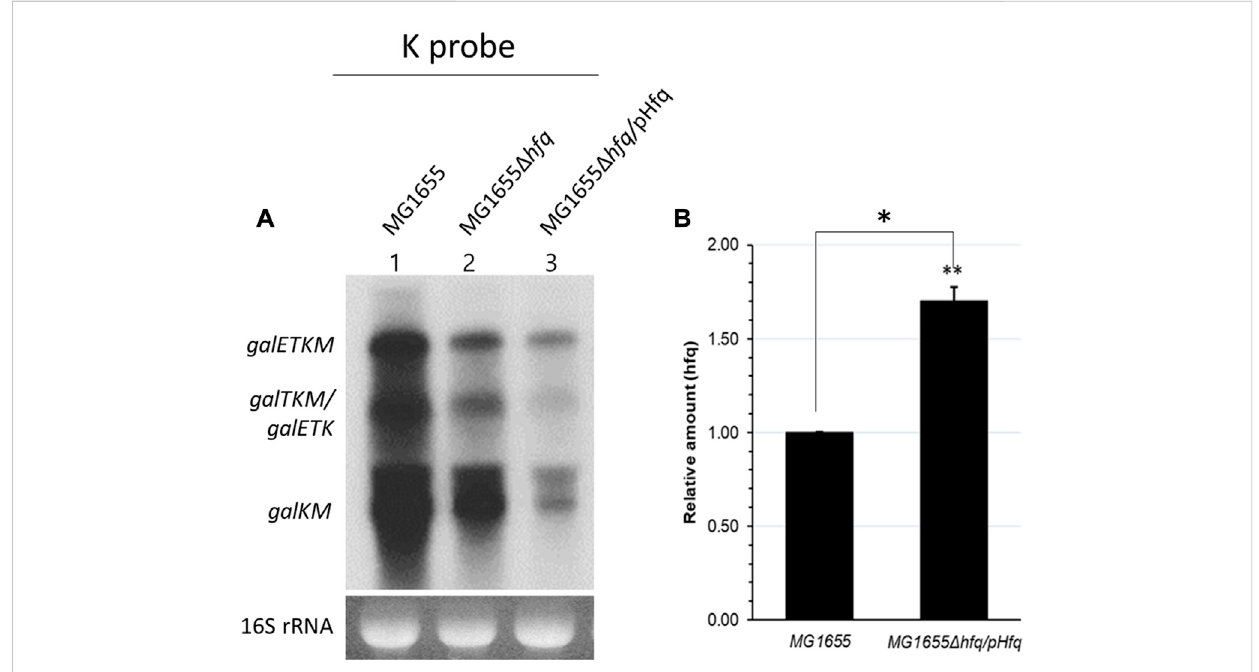
FIGURE 4 Spot 42-mediated gal mRNA degradation needs Hfq. (A) K-probed Northern blot of MG1655 (lane 1), MG1655 Δ hfq (lane 2), and MG1655 Δ hfq harboring the Hfq expression plasmid pHfq (lane 3). (B) The relative amount of hfq mRNA was measured by using qRT-PCR in MG1655 and MG1655 Δ hfq harboring pHfq plasmid. Error bars represent the mean fold-change ±standard deviation from three independent experiments. * p -value ≤ 0.05 (statistically signi fi cant).